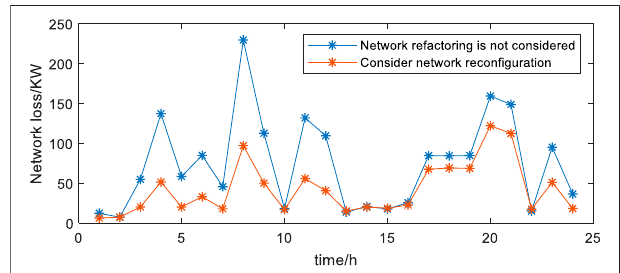
FIGURE 9 | Time-by-time network loss of the distribution network for strategy 1 and strategy 2.